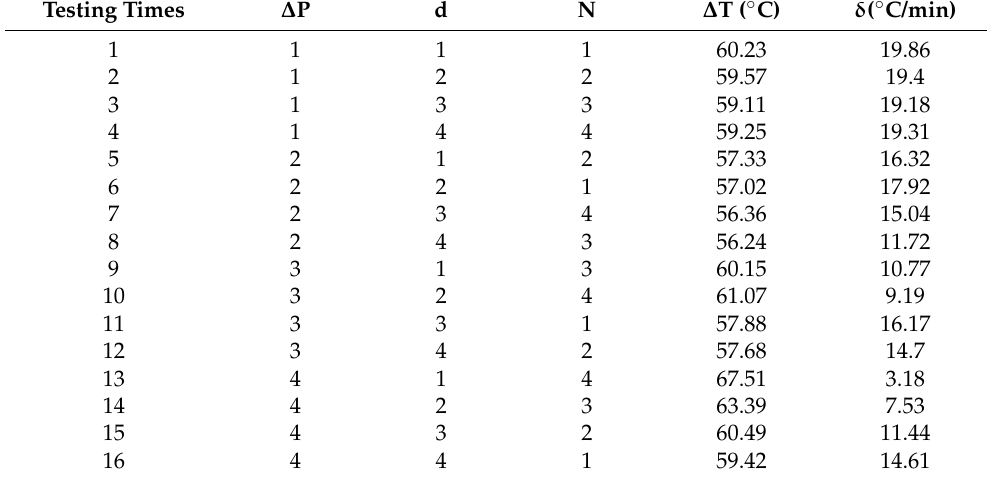
Table 7. Results of orthogonalization test.